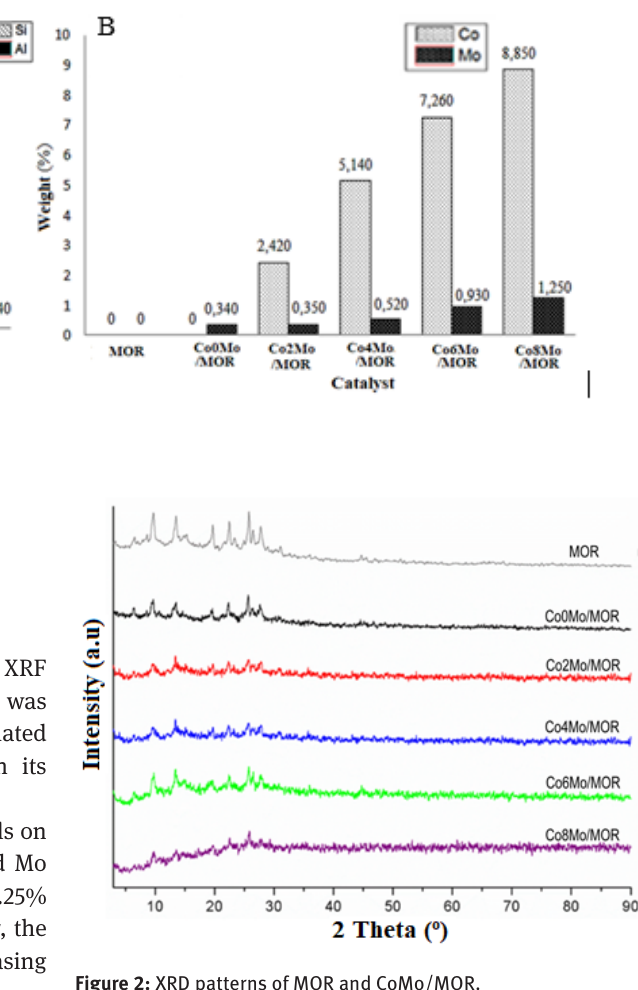
Figure 2: XRD patterns of MOR and